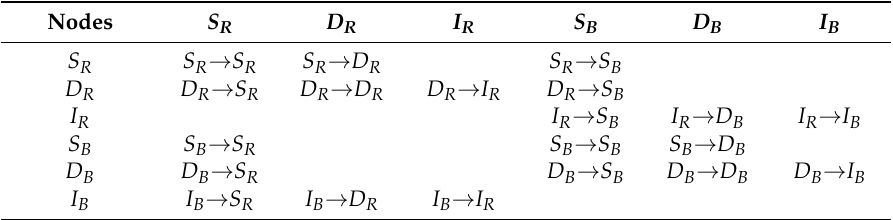
Table 1. Meta-functional edge relation types.